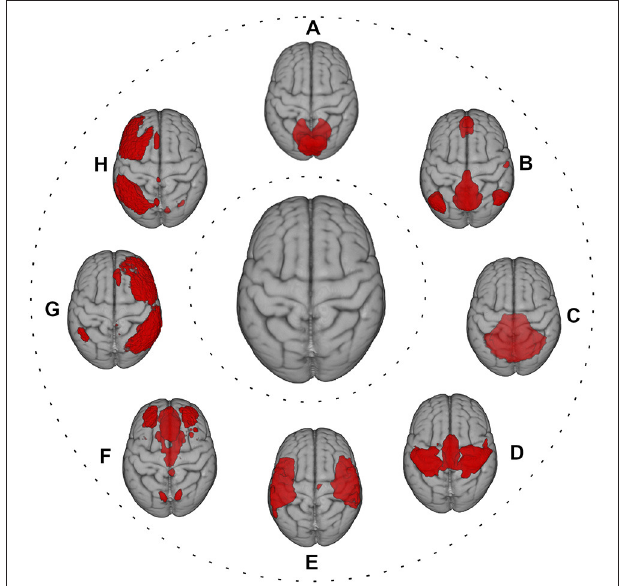
FIGURE 2 | Red color shows the most representative resting-state networks, reflecting large-scale functional patterns, overlaid onto MNI standard brain. (A) visual network; (B) default mode network; (C) cerebellum network; (D) sensorimotor network; (E) auditory network; (F) executive control network; (G) right frontoparietal network; (H) left frontoparietal